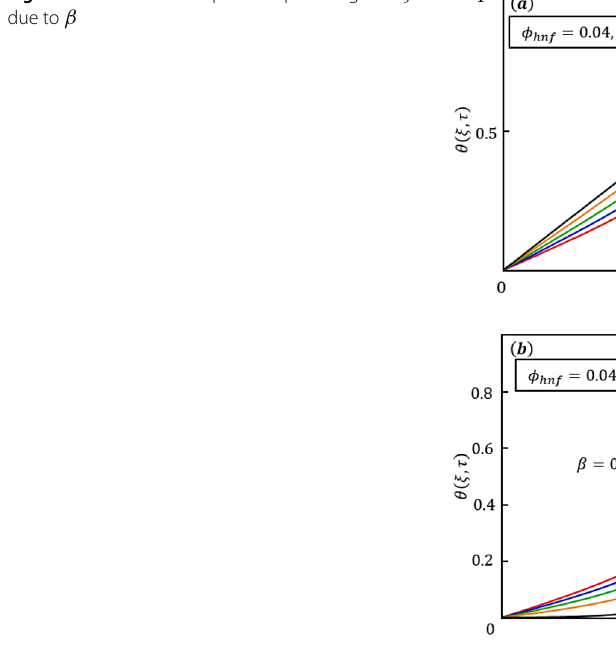
Figure 1 Variation in temperature profile against ξ due to β